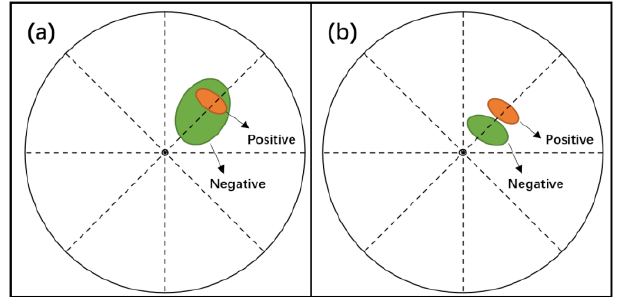
Figure 4. Types of positive and negative velocity pairs. ( a ) A large circle encloses a small circle, and ( b ) the two circles are adjacent.